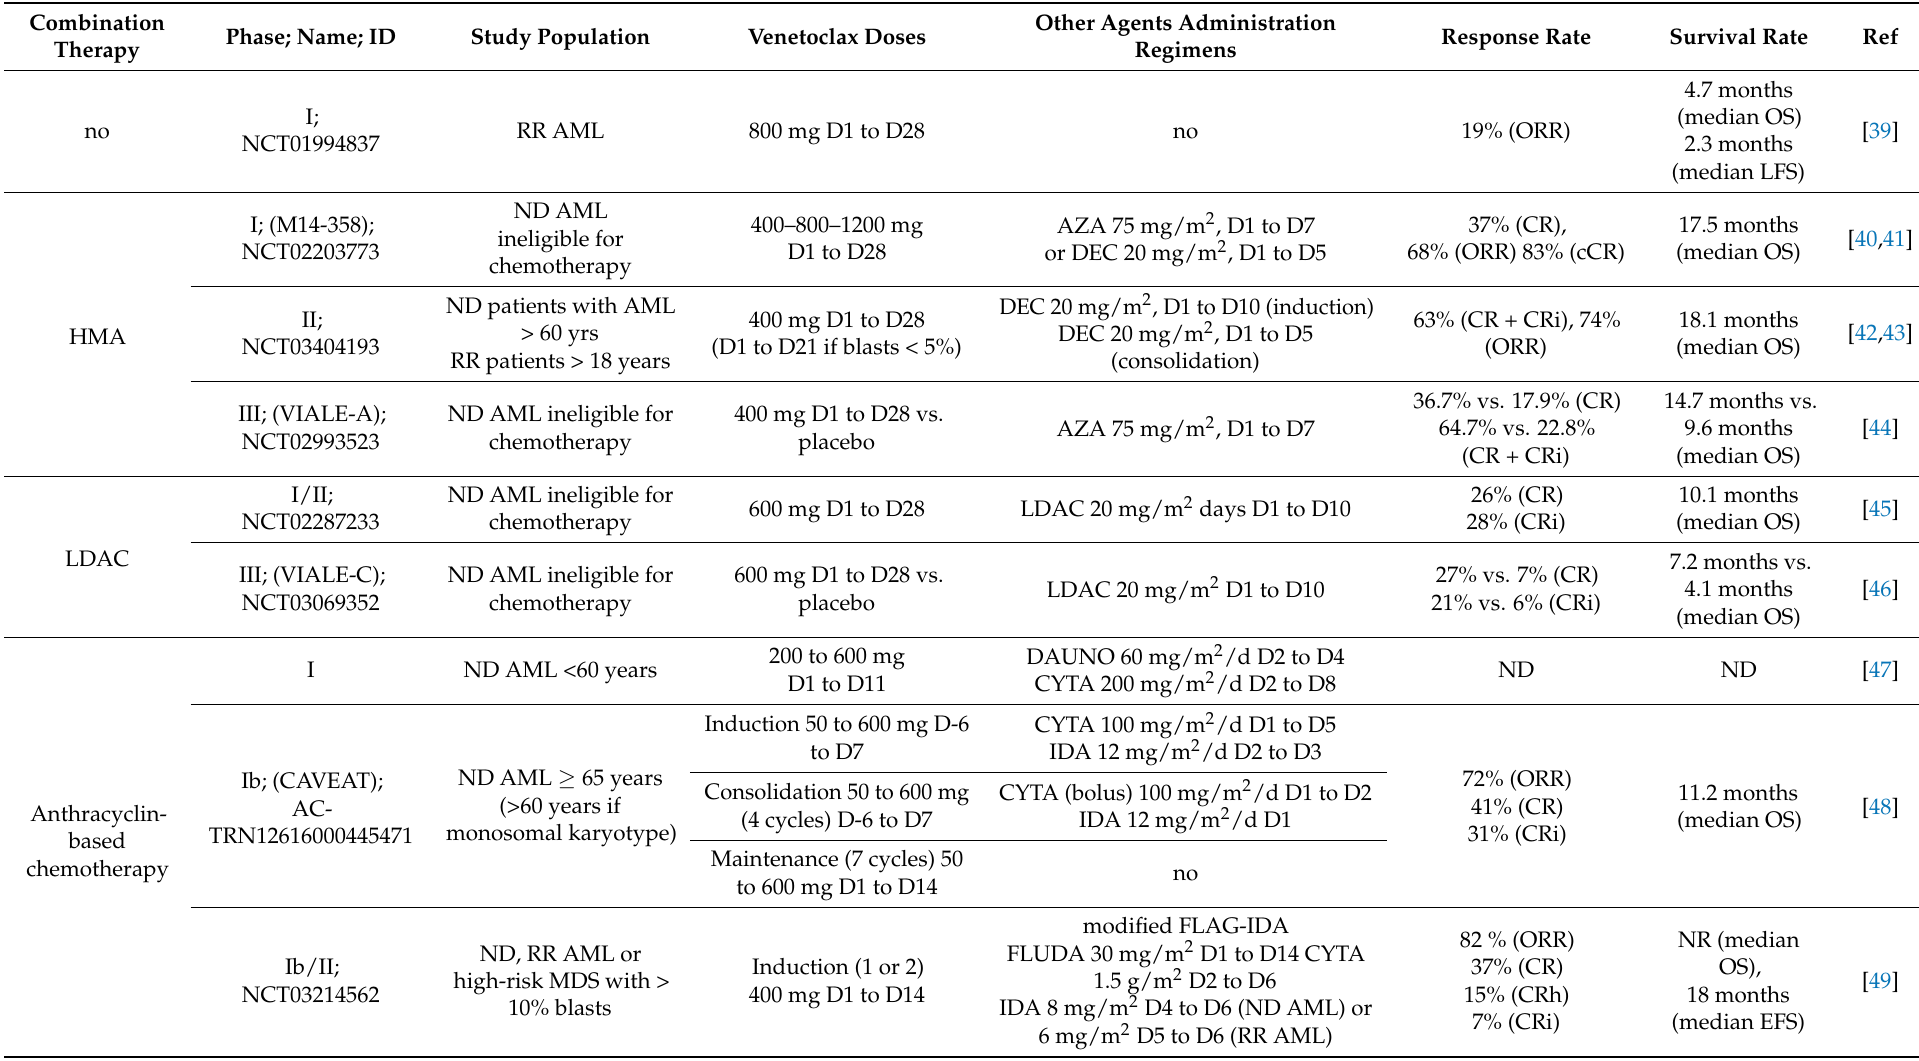
Table 1. Main studies evaluating venetoclax efficacy in AML, as monotherapy or in